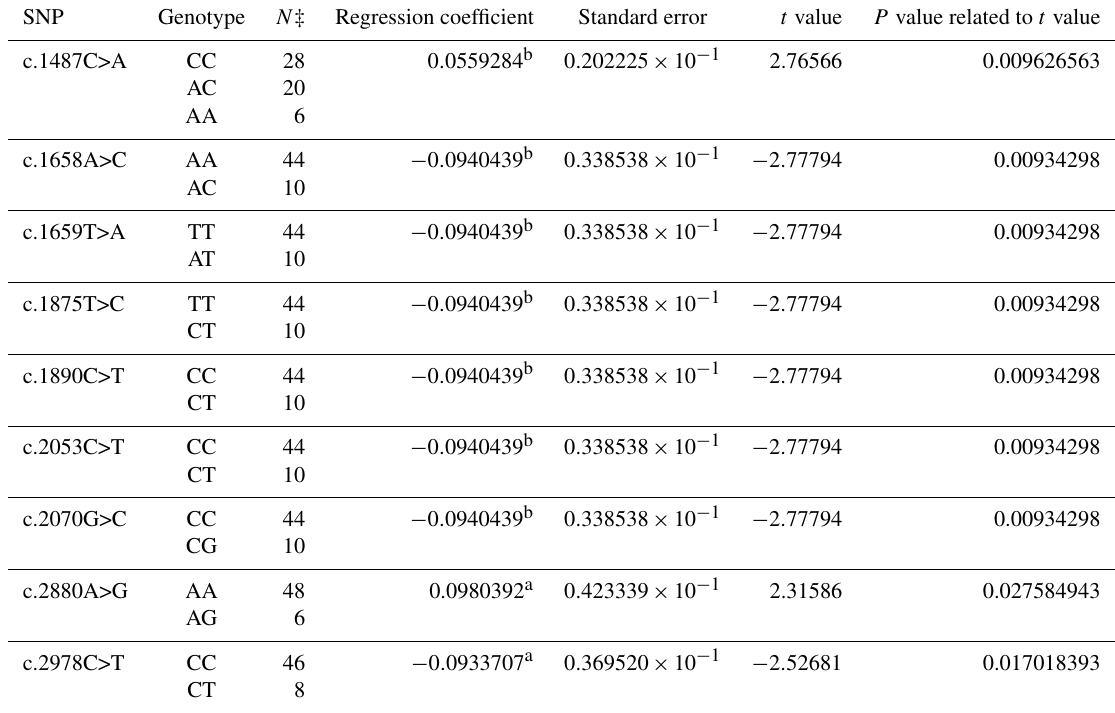
Table 3. The SNPs located in the 13th exon and 3 (cid:48) UTR region in the BMPR1B gene of the Da˘glıç breed, along with their significance levels and calculated regression coefficients.